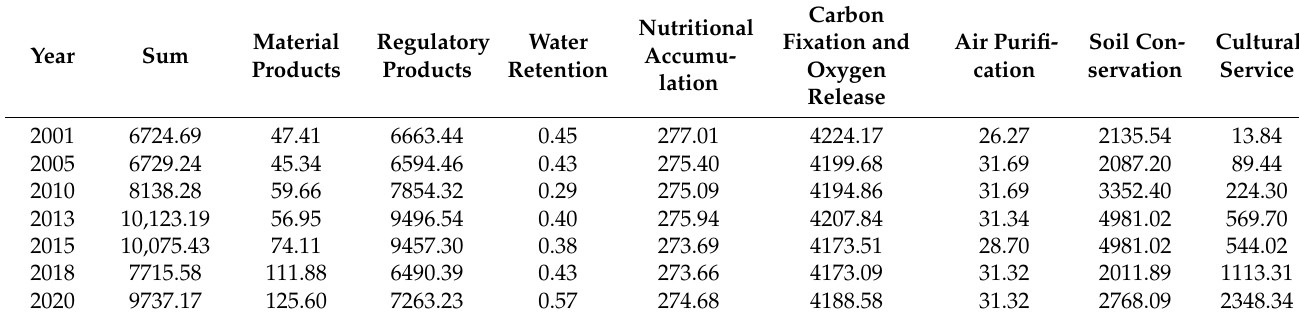
Table 3. Value of various ecological products in Zhejiang Province from 2000 to 2020.